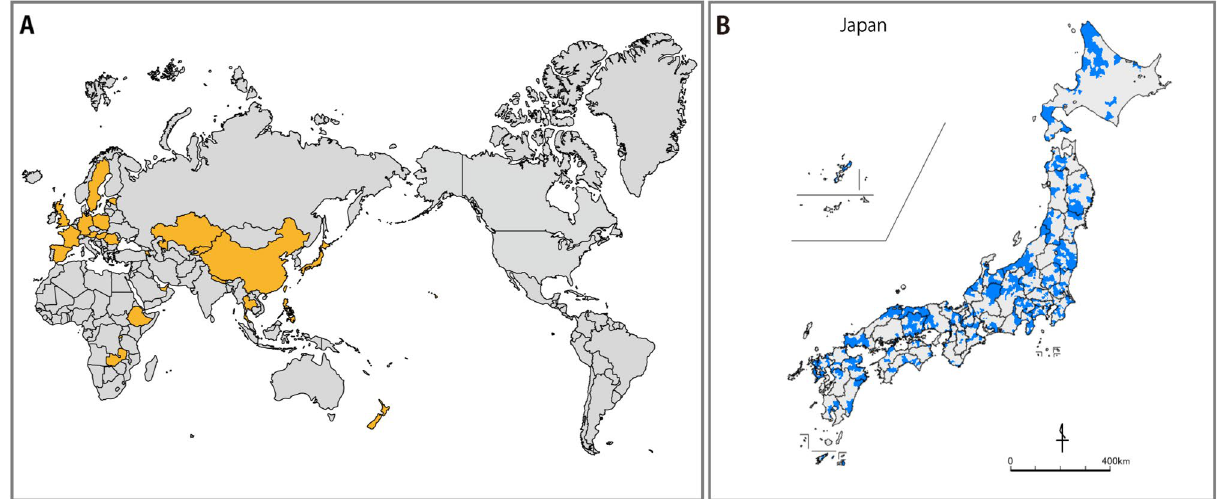
Figure 8. Locations of the tap water samples: ( A ) a map of the study countries (n = 28); ( B ) the location of sampling cities in Japan (n = 665). For the United States, the data were collected only in Hawaii. The figure was self-drawn by using Adobe Illustrator